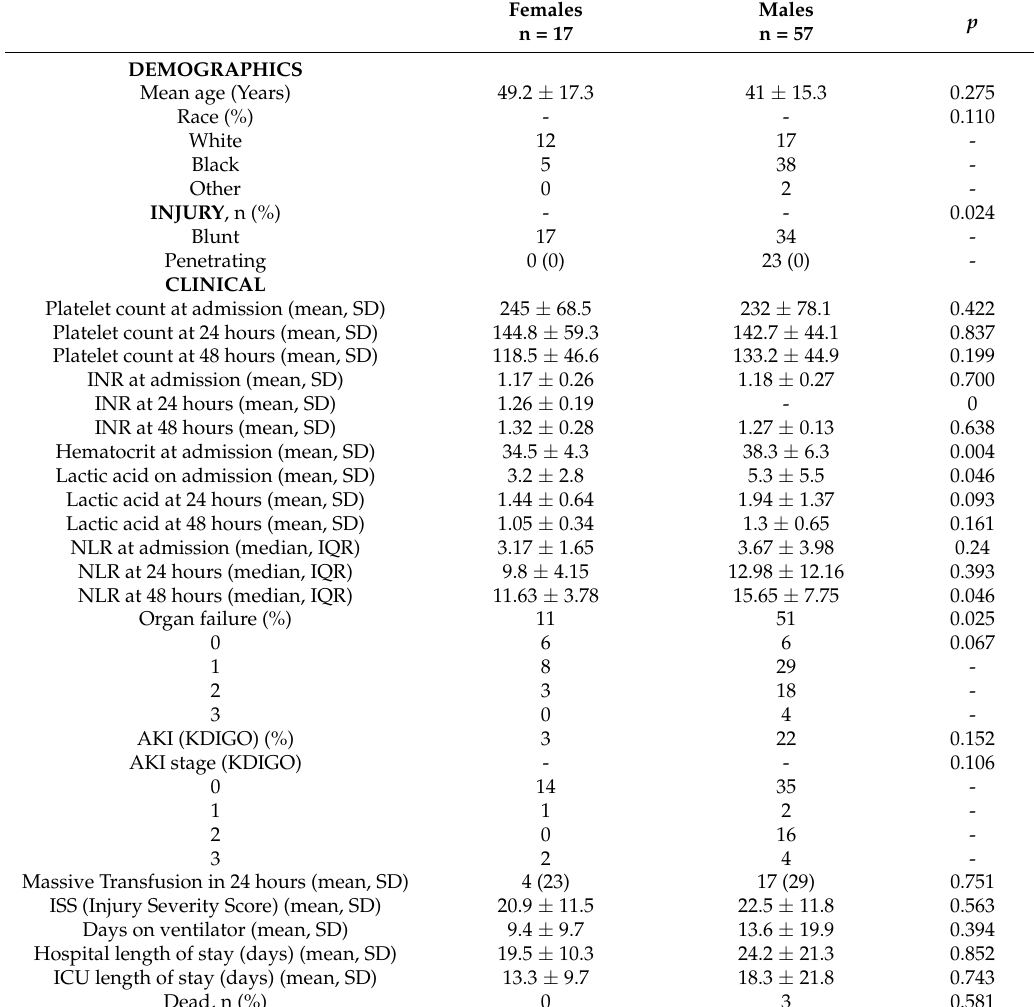
Table 2. Demographic, injury, and clinical characteristics of trauma patients in increasing trajectory (1) in both